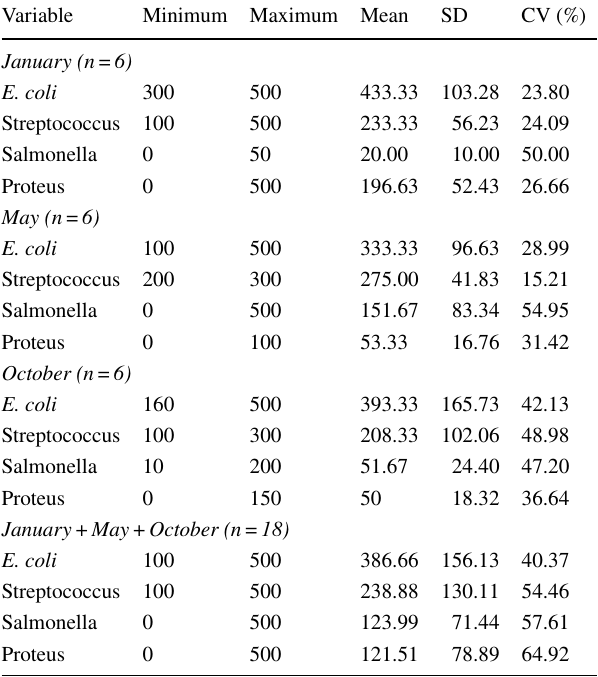
Table 4 Summary statistics of the Mezam water bacteria count for the studied period (n = 18)